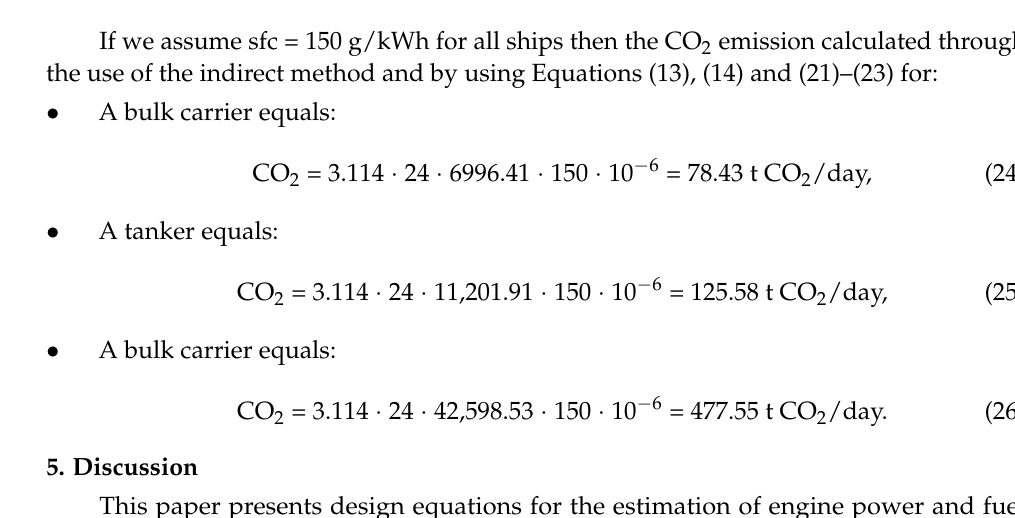
Figure 15. Specific fuel consumption (sfc) of the ship’s main engine used in the study.